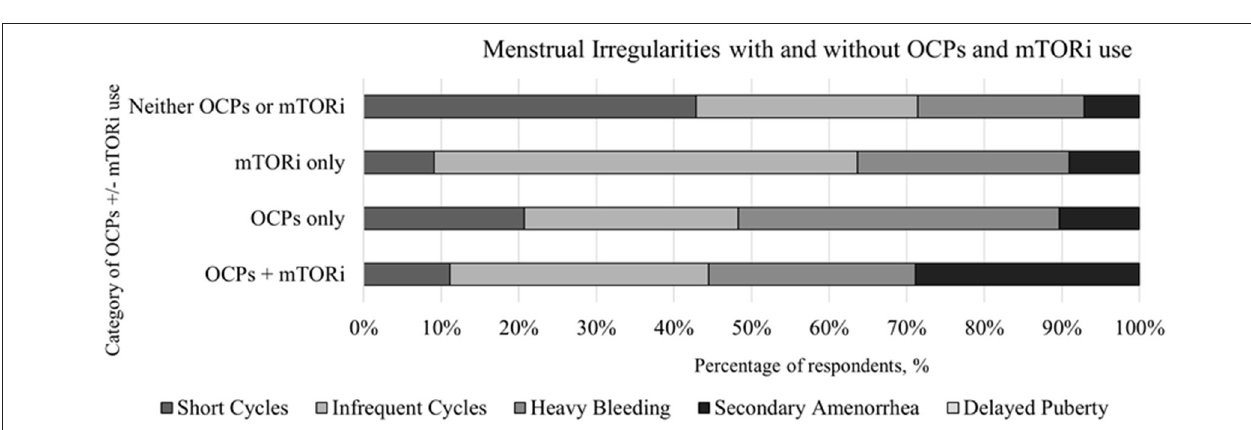
FIGURE 2 | Comparison of the menstrual irregularities present in individuals with and without the use of oral contraceptive pills (OCPs) and mTOR inhibitors (mTORi) with further subcategorization of before and after the initiation of